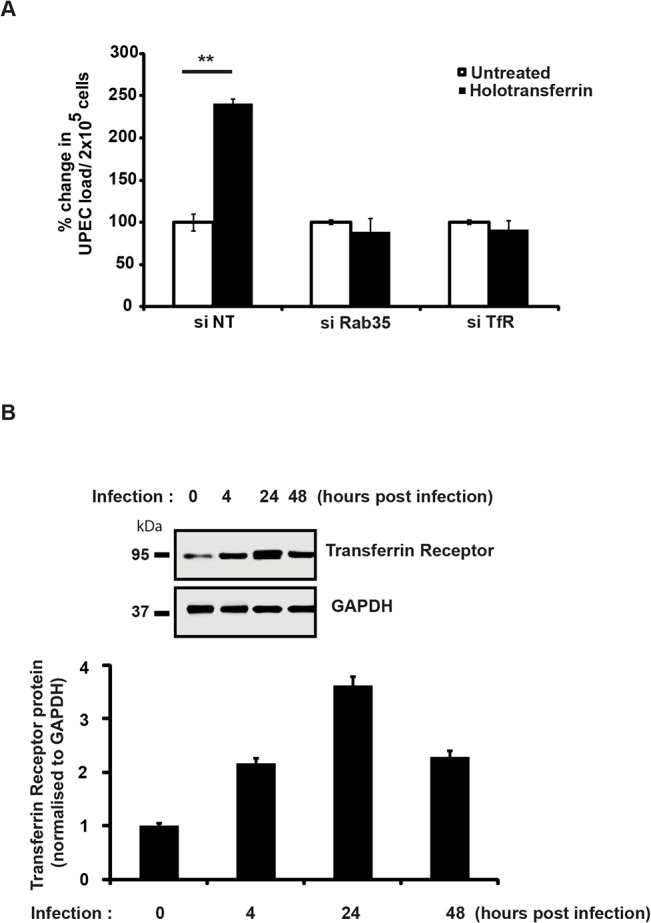
Iron supplementation is unable to support intracellular UPEC survival in the absence of Rab35 or TfR.
A. siNT, siRab35 or siTfR treated BEC cells were maintained in serum-free conditions 4 h prior to infection and were subsequently left in serum free medium for the rest of the duration of the experiment. Cells were infected with UPEC at MOI 500 for 2 h. Following infection, and gentamycin treatment, the cells were washed and left in RPMI with gentamycin (10μg/ml) and treated with 50μg/ml holotransferrin or left untreated for further 24 h. The cells were then lysed and plated for enumeration of intracellular bacteria by cfu assay. Results are expressed as % change in bacterial load/ 2x105 cells. Values shown represent means ± standard deviations of results of three experiments. (** p<0.01 vs untreated siNT values). B. UPEC infection upregulates TfR at the protein level. BEC cells were infected with UPEC and TfR protein expression was analyzed at 4, 24 and 48 h post infection by Western blot analysis. Quantitation of the Western blots using the software ImageJ is shown (bottom panel). Relative densitometric data (TfR/GAPDH) is shown. Values shown represent means ± standard deviations of results of three experiments. (* p<0.05 vs 0 h time point values).